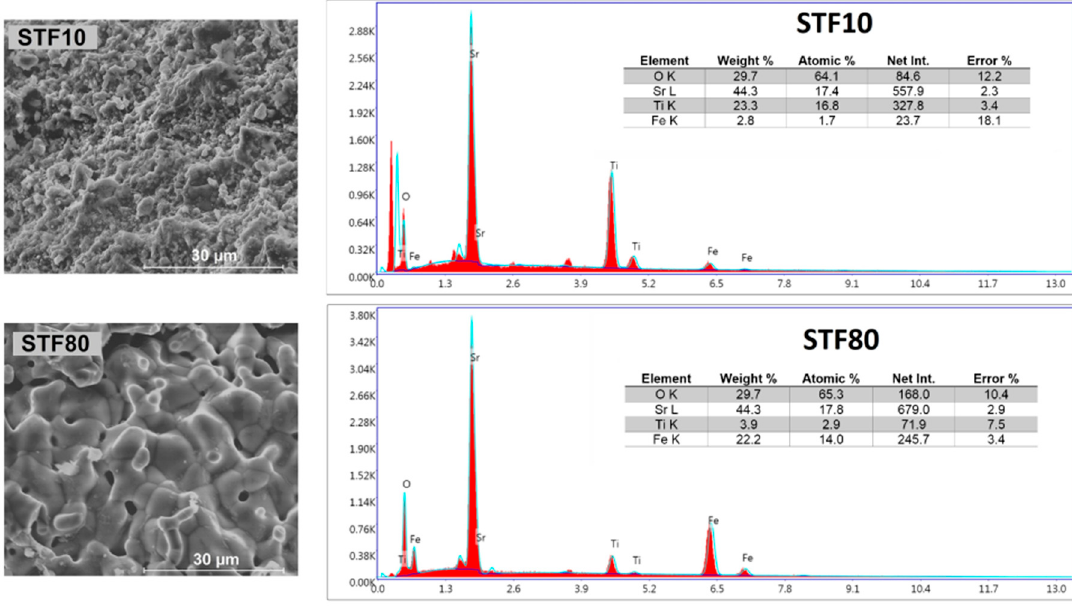
Figure 3. SEM micrographs and EDX spectra results of cross-sections of SrTi 1 − x Fe x O 3 − x / 2 − δ for x = 0.1 and 0.8.